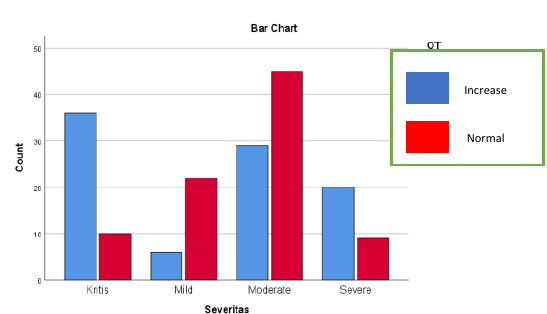
Figure 2. Diagram of the Relationship between Elevated AST and Mortality